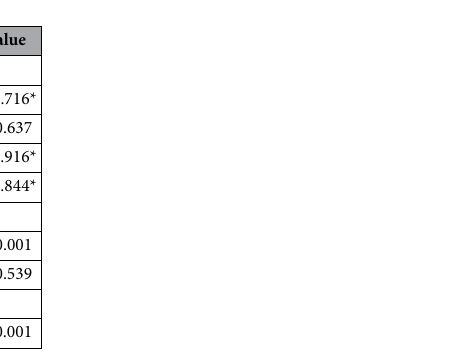
Table 1. Baseline characteristics. Data presented as n (%); continuous data, mean ± SD. * MP match